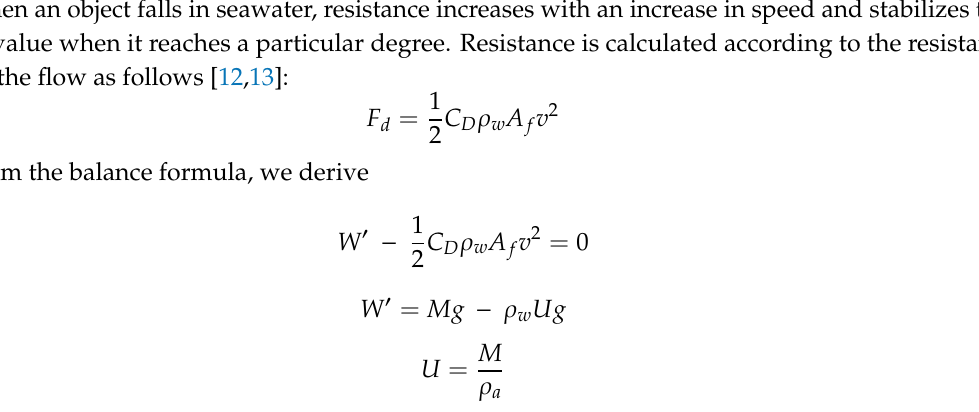
Figure 3. Force analysis of an anchor in the water.